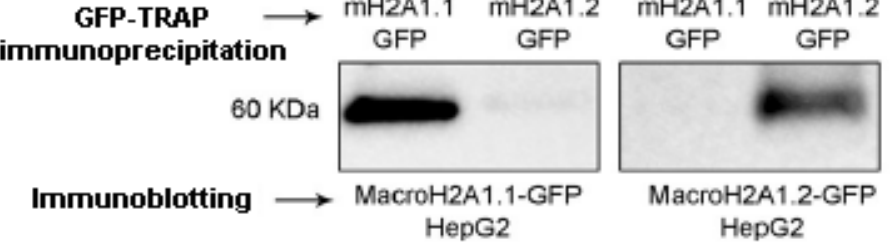
Figure 2. Immunoblotting analysis to confirm macroH2A1 splicing isoforms isolation from the fraction eluted from HepG2 overexpressing macroH2A1.1 ‐ GFP (mH2A1.1 ‐ GFP) and macroH2A1.2 ‐ GFP (mH2A1.2 ‐ GFP) following immunoprecipitation with GFP ‐ Trap®®.